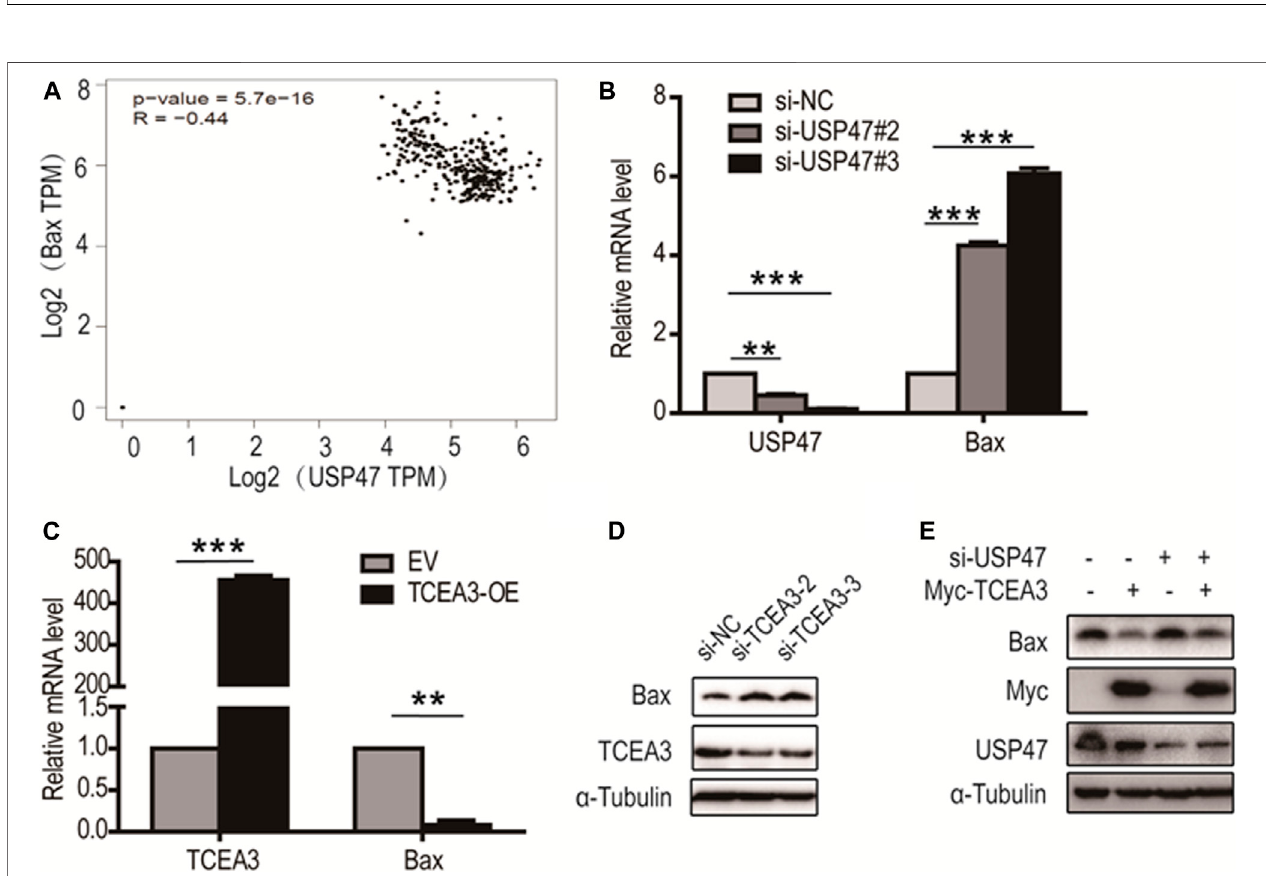
FIGURE6| RegulationofBaxtranscriptionbyTCEA3. (A) USP47andBaxexpressionswerecorrelated.DatawereretrievedfromGEPIAdatabase. (B) BaxmRNA level in HCT116 cells was increased after the transfection of USP47-targeted siRNAs for 24 h ** p < 0.01, *** p < 0.001. (C) The mRNA level of Bax was reduced in HCT116 cells after the transfected of TCEA3-expressing plasmid for 24 h ** p < 0.01, *** p < 0.001. (D) Bax was increased in HCT116 cells following transfection with TCEA3-targetedsiRNAsfor48 hasexaminedbyanti-Baximmunoblotting. (E) TheexpressionofBaxinHCT116cellstransfectedwithTCEA3-expressingplasmid and/or USP47-targeted siRNAs for 48